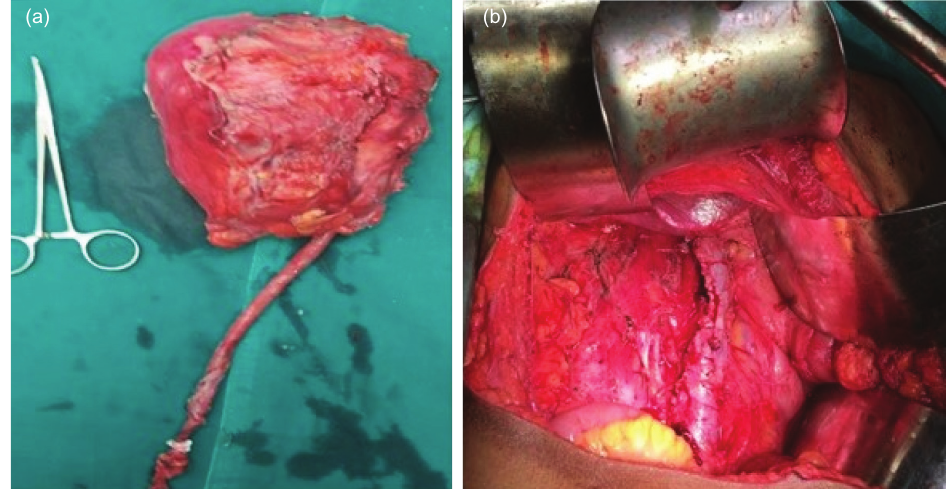
Figure 2: Intra-operative pictures of Case 4. (a) Showing tumor specimen of size 12.5 × 8 × 4 cm involving renal pelvis with grossly hydronephrotic right kidney. (b) Showing post-nephroureterectomy right renal bed with repaired IVC after excising involved cuff. IVC, inferior vena